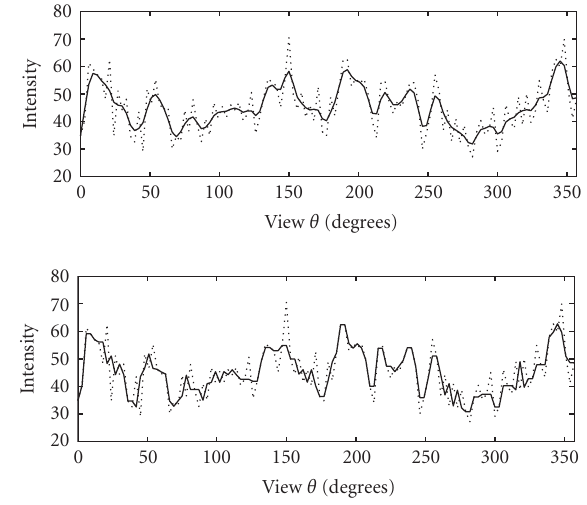
Figure 3: A selected locus-signal in the stackgram domain. The locus-signals contribute to the intensity values of the pixels in the reconstructed image. In the upper plot, the signal in the solid line was smoothed with a linear filter, whereas the same signal was pro- cessed with a nonlinear filter in the lower plot. The shown signal in the dashed line is the same initial noisy signal in both plots. The fil- tered signals illustrate the di ff erent performance of linear and non- linear filters as well; nonlinear filters often preserve sharp transitions in signals better than linear